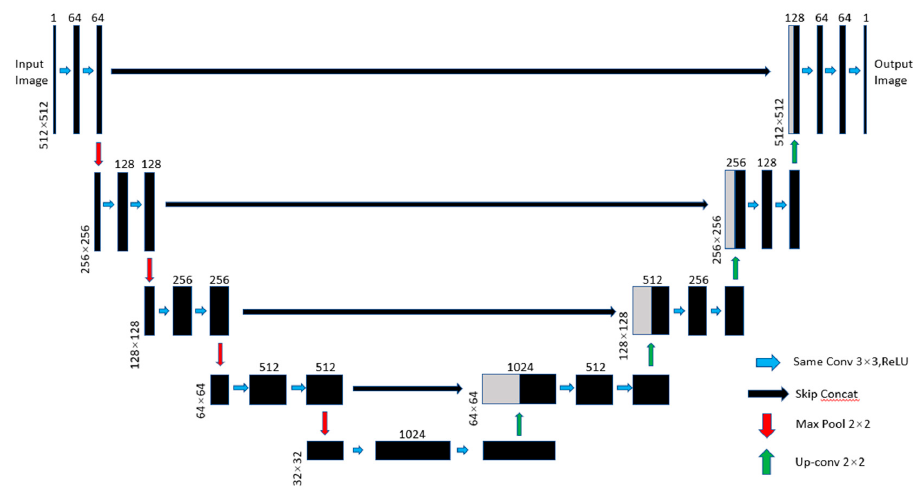
Figure 3. The architecture of U-Net.